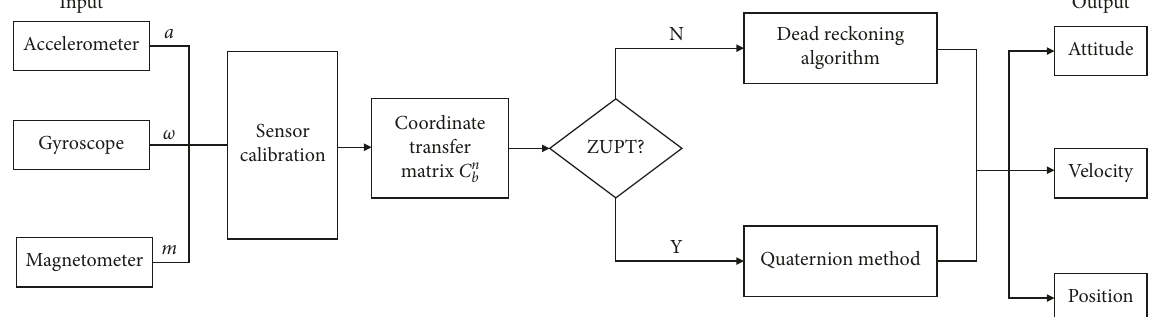
Figure 1: Inertial pedestrian navigation system